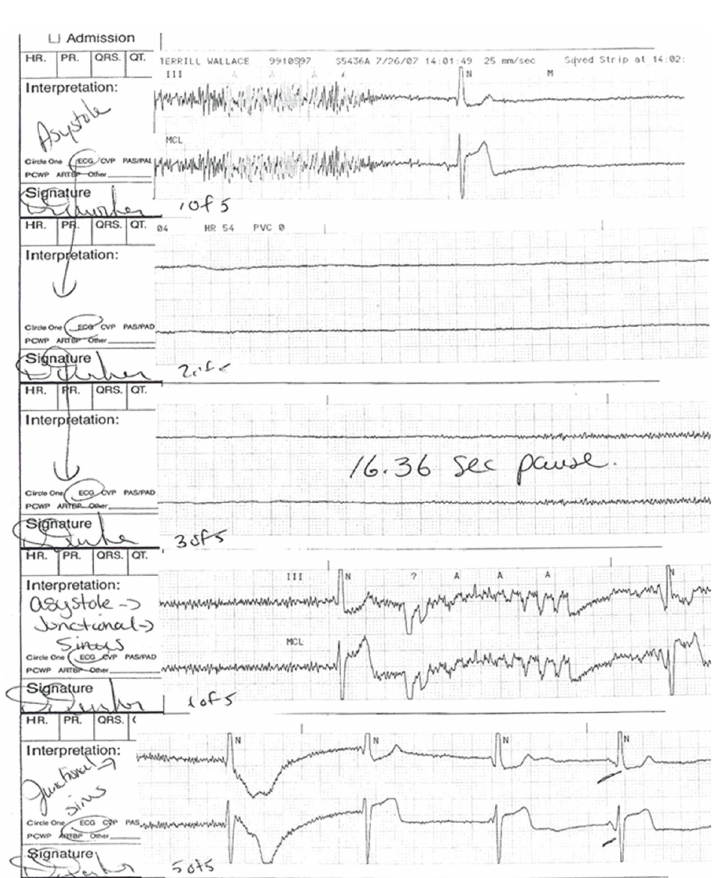
Figure 2: Cardiac telemetry reading showing asystole for 16.36